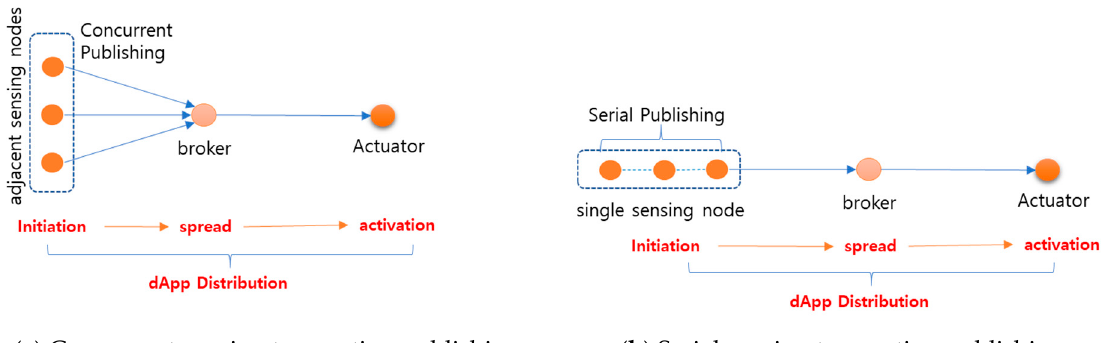
Figure 8. Smart contract types of node classification.